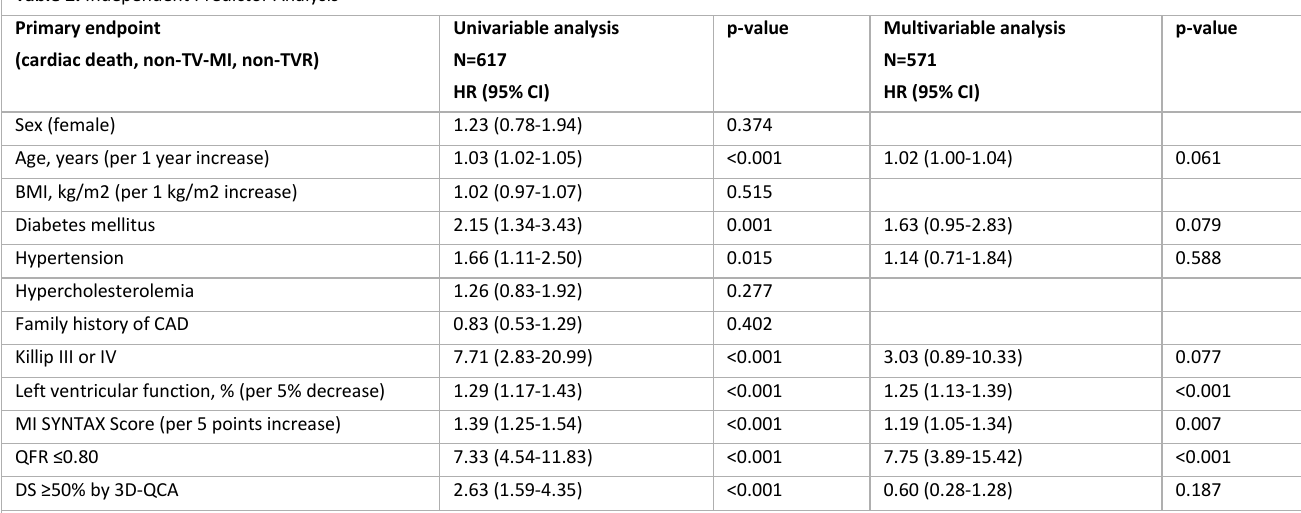
Table 2. Independent Predictor